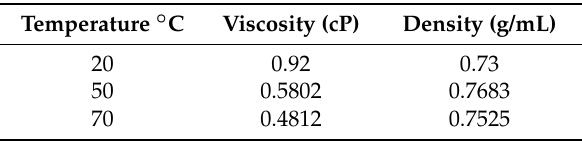
Table 1. Synthetic oil